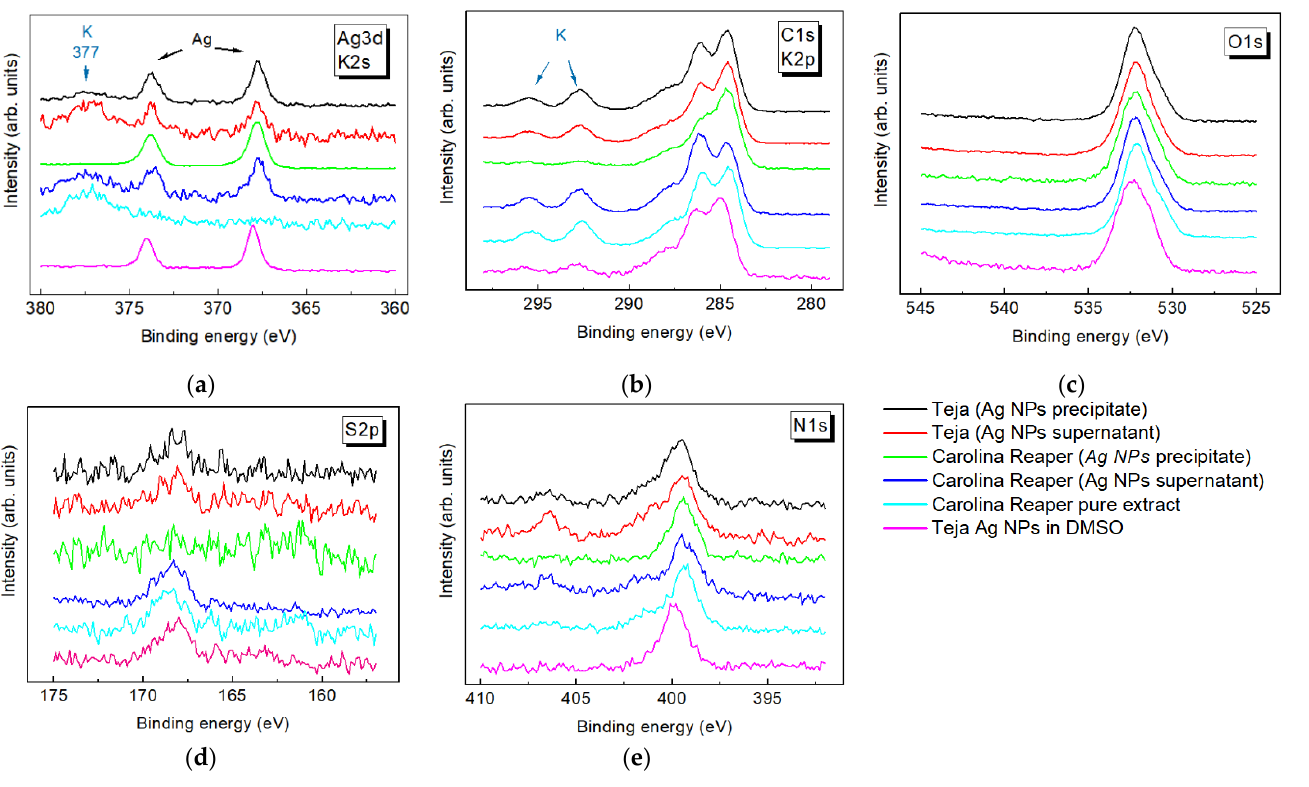
Figure 2. High-resolution XPS spectra of the Ag NPs synthesized using pepper extracts: Ag ( a ), C ( b ), O ( c ), S ( d ), N ( e ). O ( c ), S ( d ), N ( e